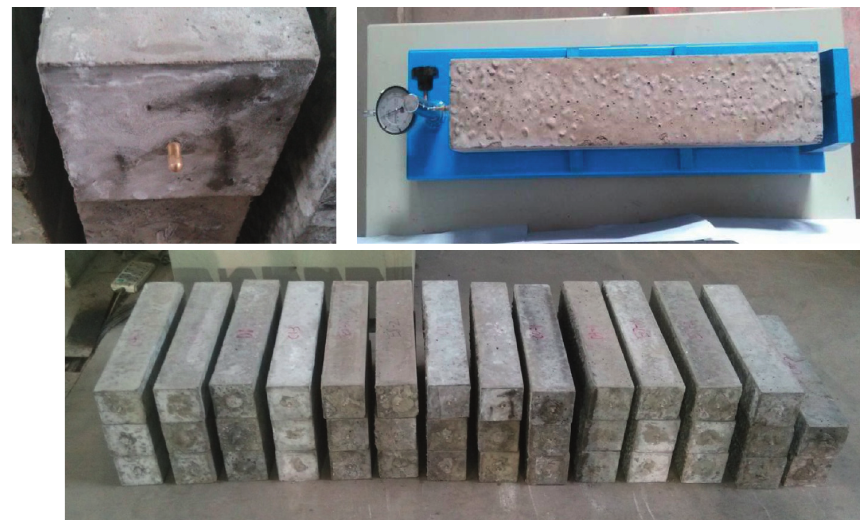
Figure 4: Shrinkage test device and concrete specimen.